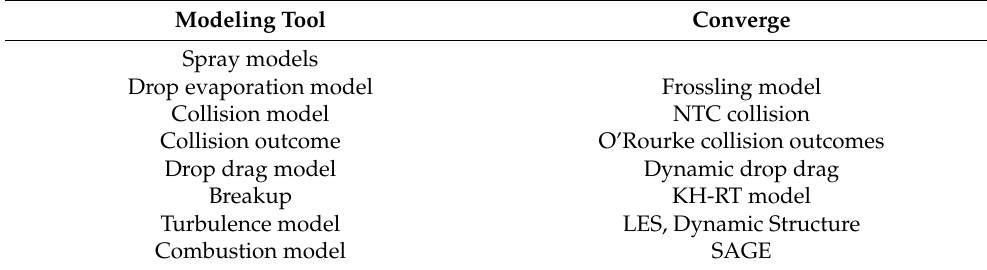
Table 1. Numerical